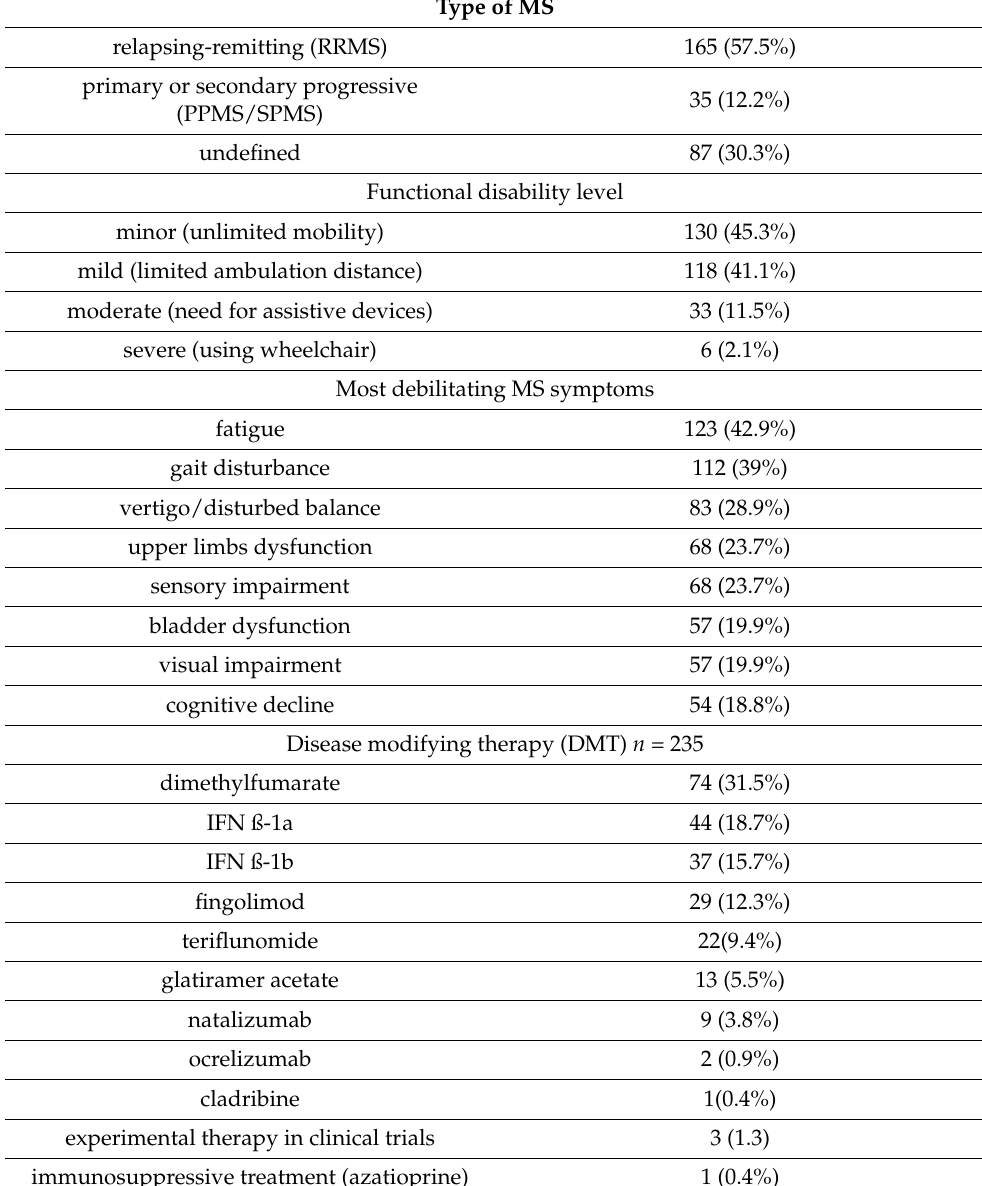
Table 2. Clinical characteristics of the study